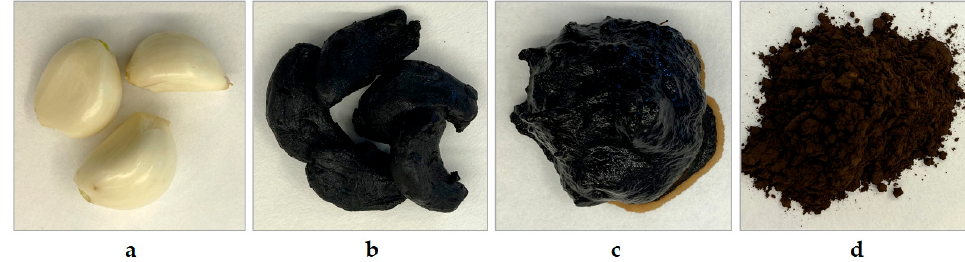
Figure 2. Plant material used in the research: ( a ) WG—white garlic, ( b ) BG-C—black garlic cloves, ( c ) BG-S—black garlic spread and ( d ) BG-S—black garlic spread.